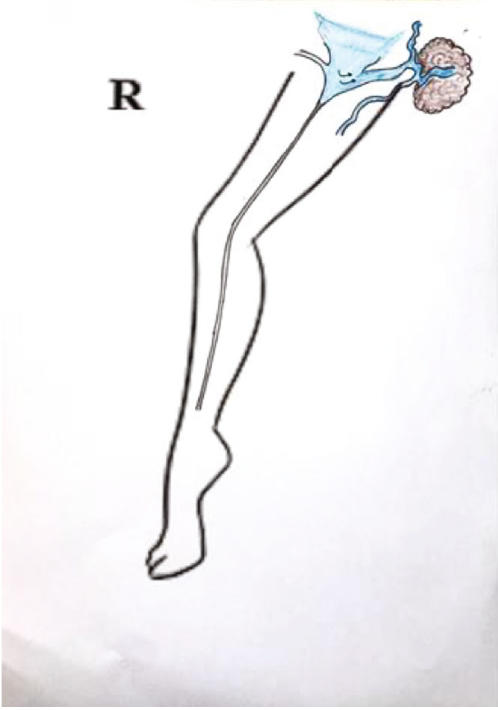
Figure 7: Schematic diagram showing recurrence of varicose veins around the groin region due to a lymph node